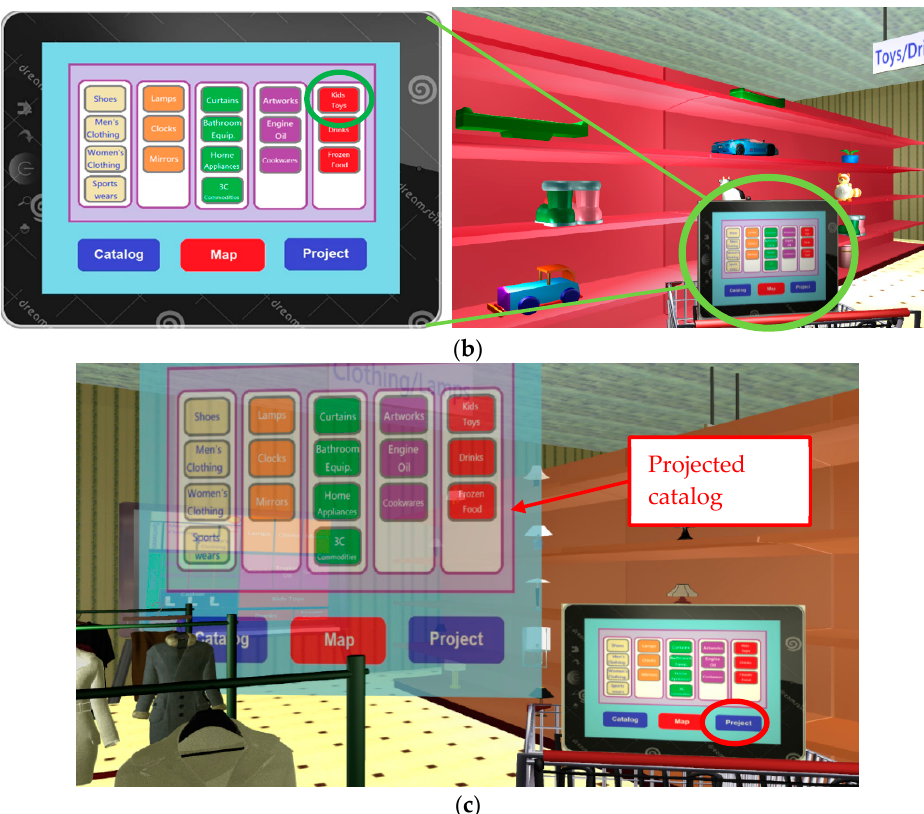
Figure 2. Cross-zone navigation system: ( a ) a simulated tablet computer displays a catalog of products affixed to the trolley. When the consumer selects the desired section, the VR display jumps to the section (e.g., lamps section); ( b ) jumps to the kid’s toys section. ( c ) If the catalog is not clearly displayed, the consumer can click the “projection” button, and the catalog is enlarged and projected in front.